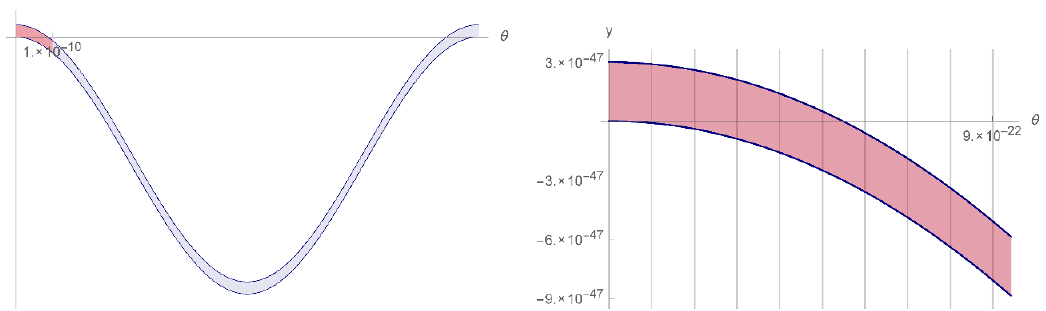
Figure 1 . Left: the shaded region is the portion of the region in ( (cid:18); y ) space that produces an anthropically allowed value for the c.c., as determined by eq. (4.5). The red shading is the portion of this region for which (cid:18) < 10 (cid:0) 10 [not drawn to scale]. This shows that values of (cid:18) of order one are favored by the c.c. anthropic selection. Right: zoomed in to very small (cid:18) , drawn to